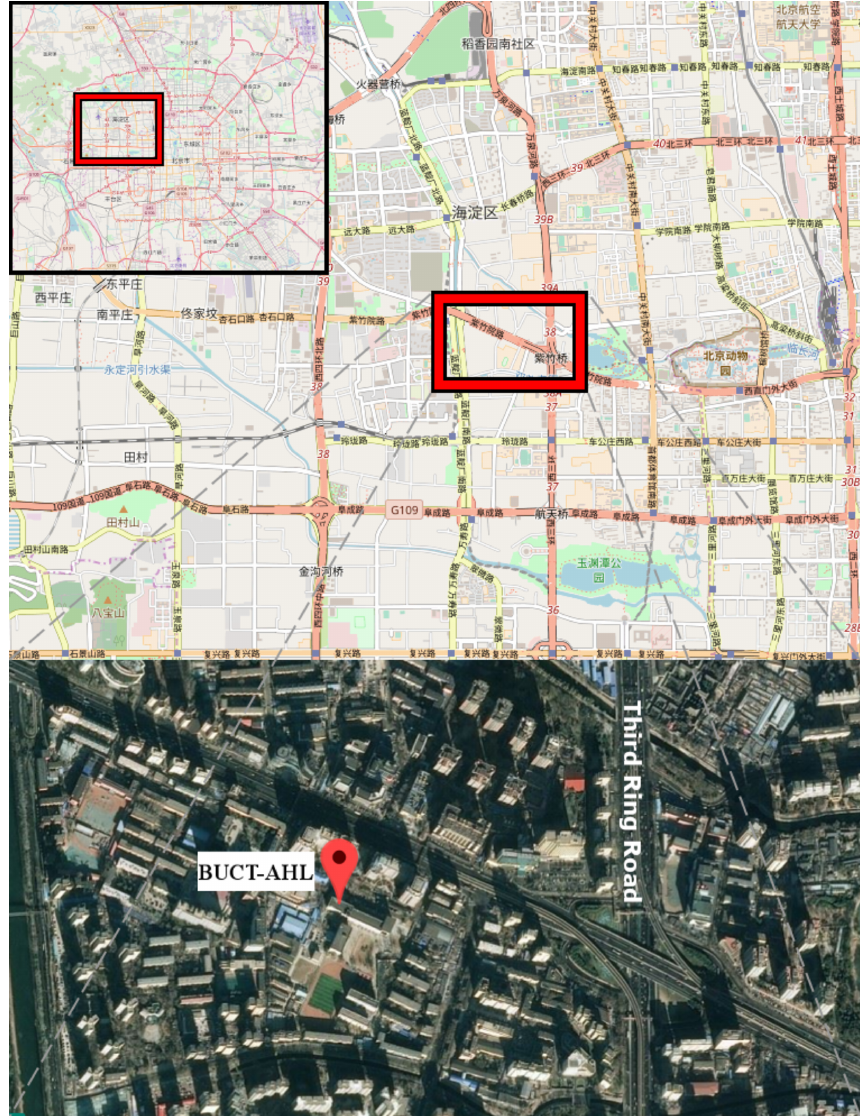
Figure 1. Location of the BUCT-AHL site within the Beijing metropolitan area. © OpenStreetMap contributors 2022. Distributed under the Open Data Commons Open Database License (ODbL)